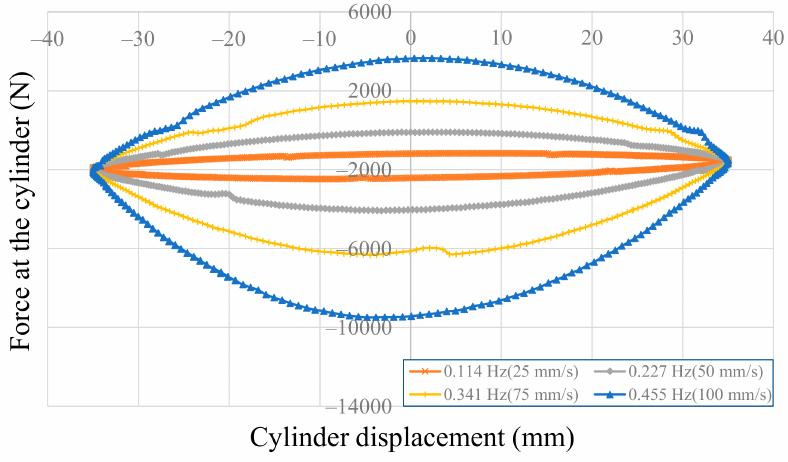
Figure 14. Force-velocity results from test when applied valve current was 360 mA (command